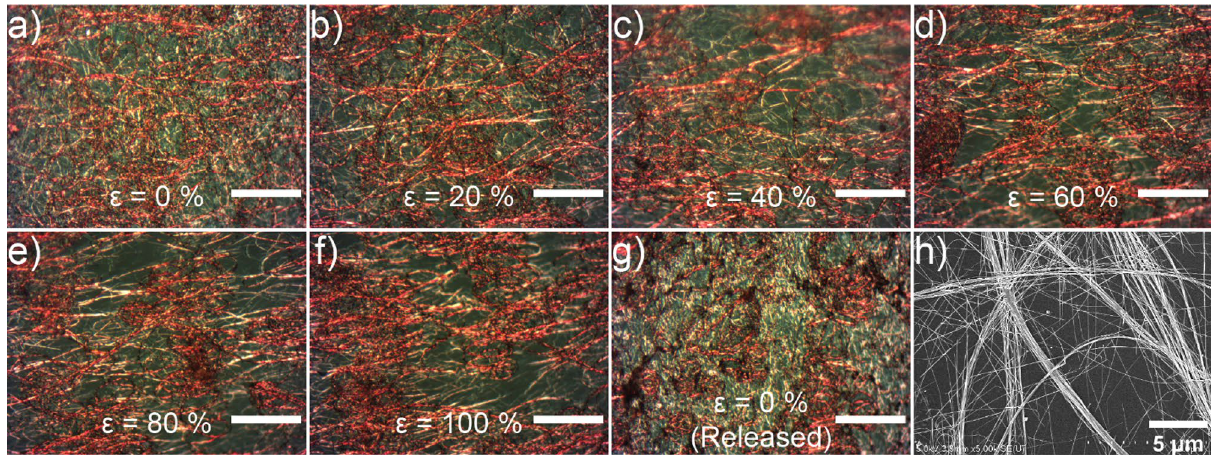
Figure 2. ( a – g ) Optical microscopy images of Cu NW electrode under various strains (from 0 to 100%) (Scale bars correspond to 50 μm), ( h ) FE-SEM image of Cu NWs deposited on PDMS by spray